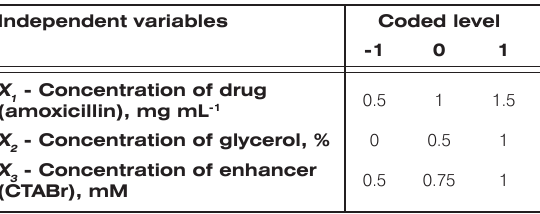
Table 1. Independent variables and experimental domain of Box Behnken Experimental Design. Independent variables